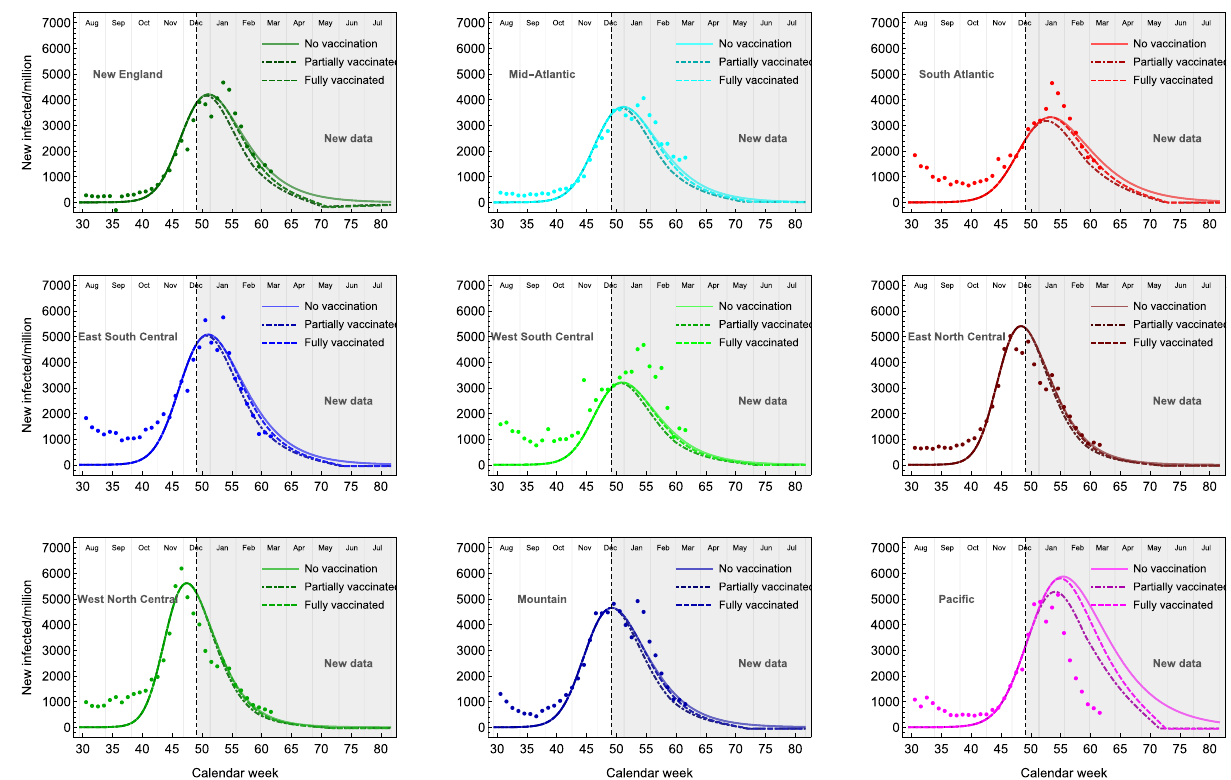
Figure 7. Results of the eRG solutions for the second wave with a vaccination campaign based on the data. Here, we consider a vaccination rate linearly increasing in time, with slopes given in Table 4. The eRG parameters are the same used for Fig. 5, based on data until December 28,